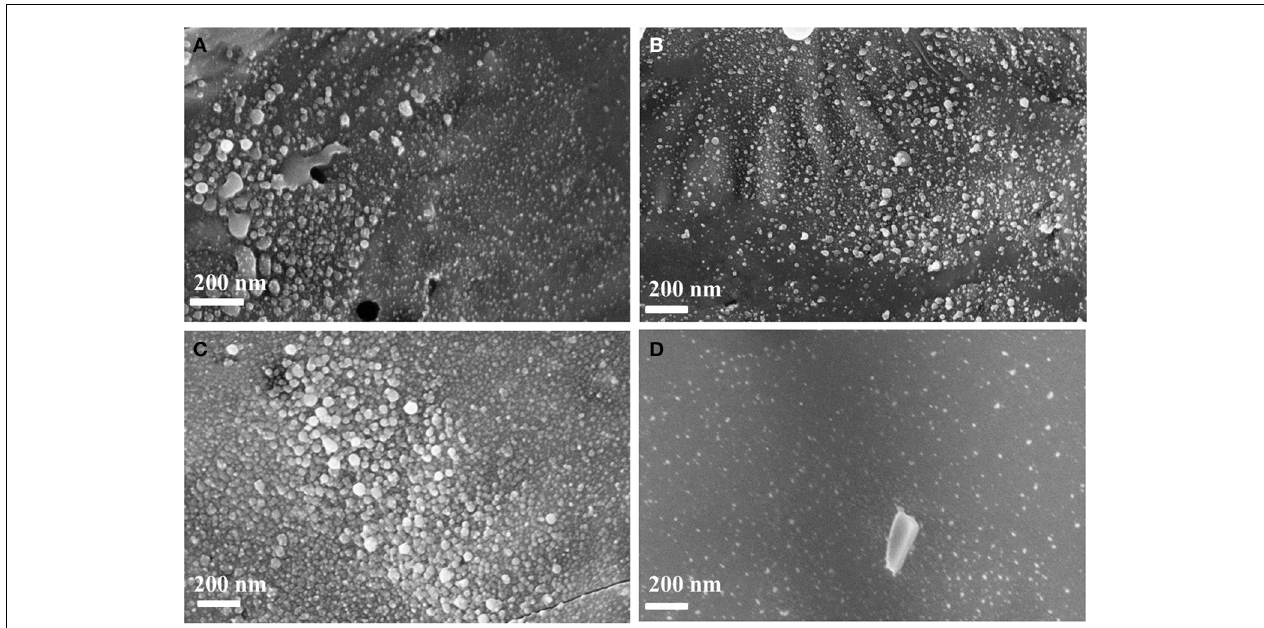
ABSORPTION AND PL RESULTS